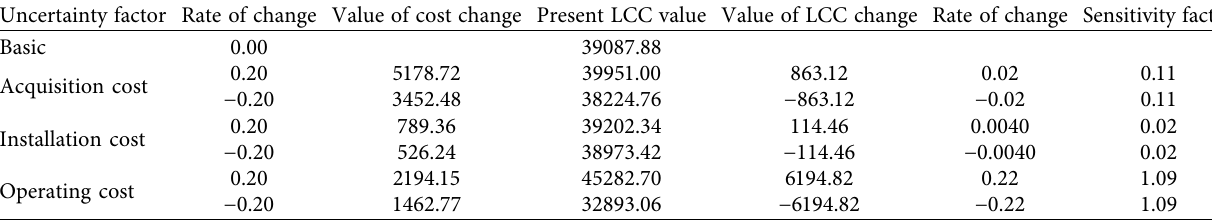
Table 8: Changes in the present value of Option 1 (million RMB).